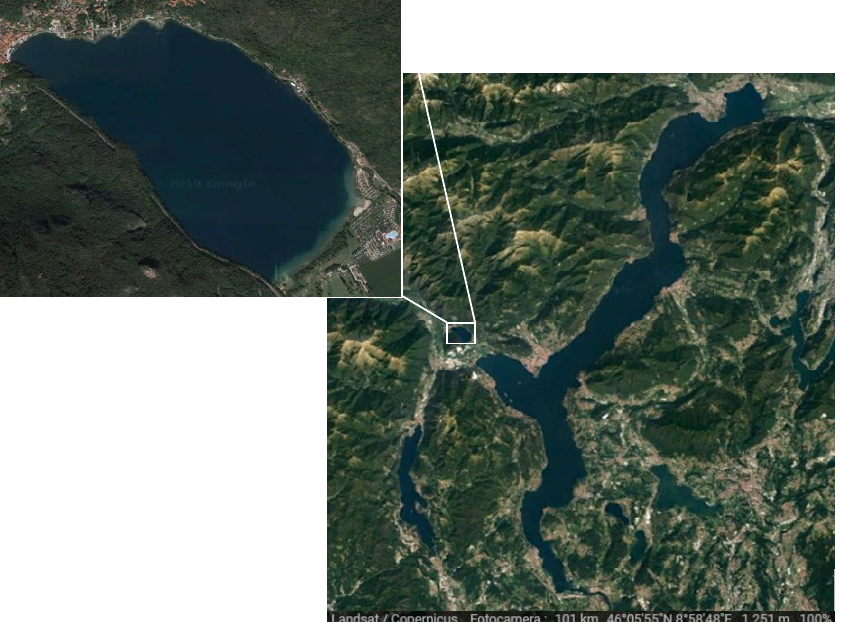
Figure 1. Lake Mergozzo satellite view (from Google Earth).